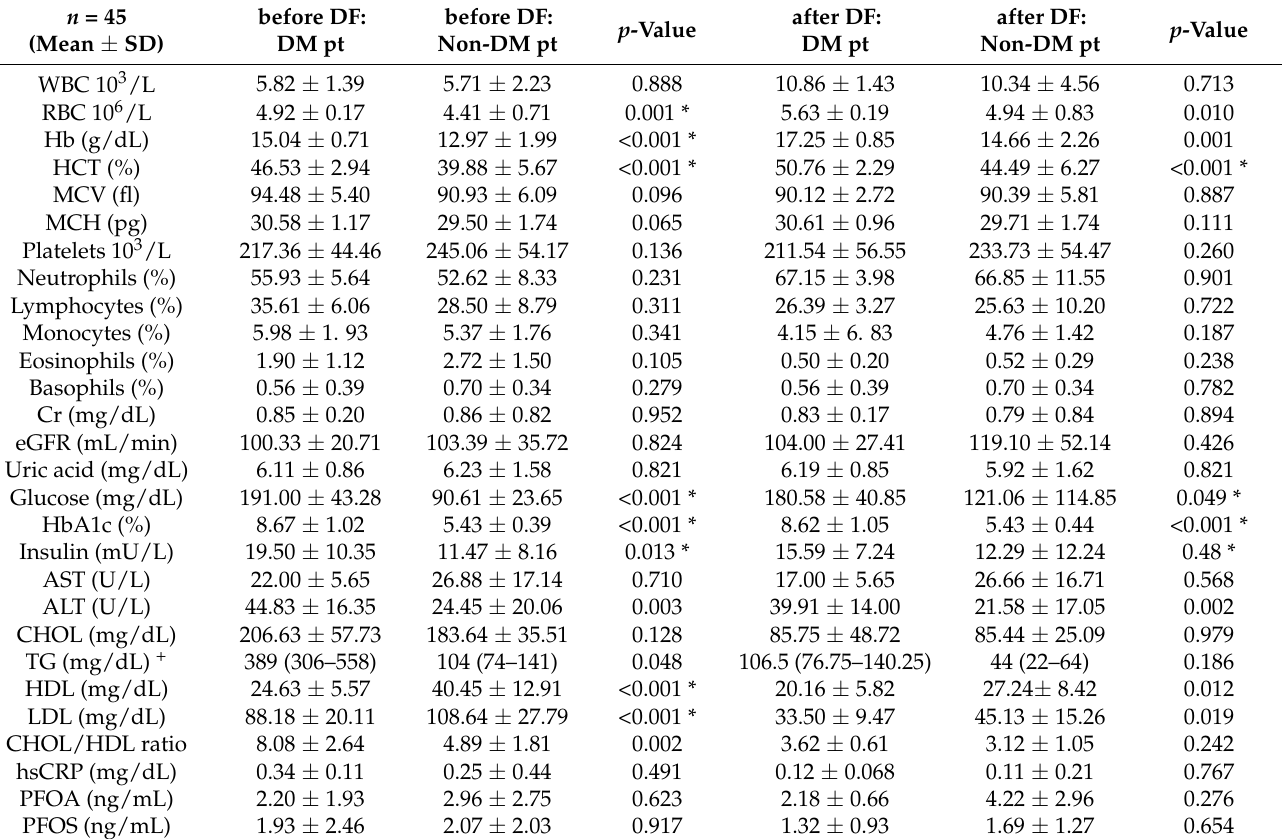
Table 3. Comparison of DM (n = 11) vs. non-DM (n = 31) patients before and after